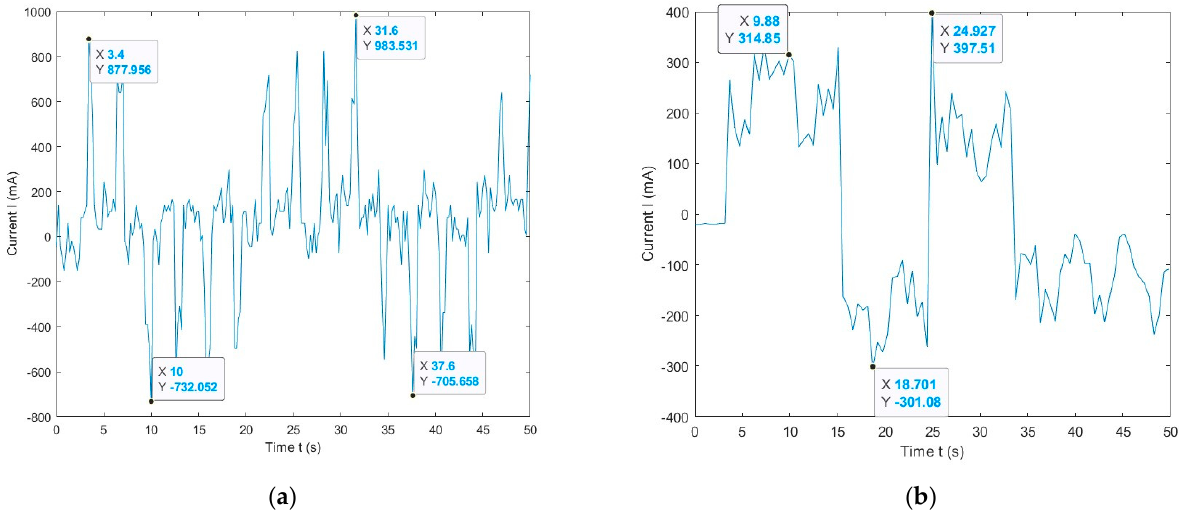
Figure 21. Variation in the current provided by the ACS712-05 sensor in the bidirectional operation of the Dynamixel MX64AT servomotor: ( a ) for a 10-bit ADC and ( b ) for a 16-bit ADC.